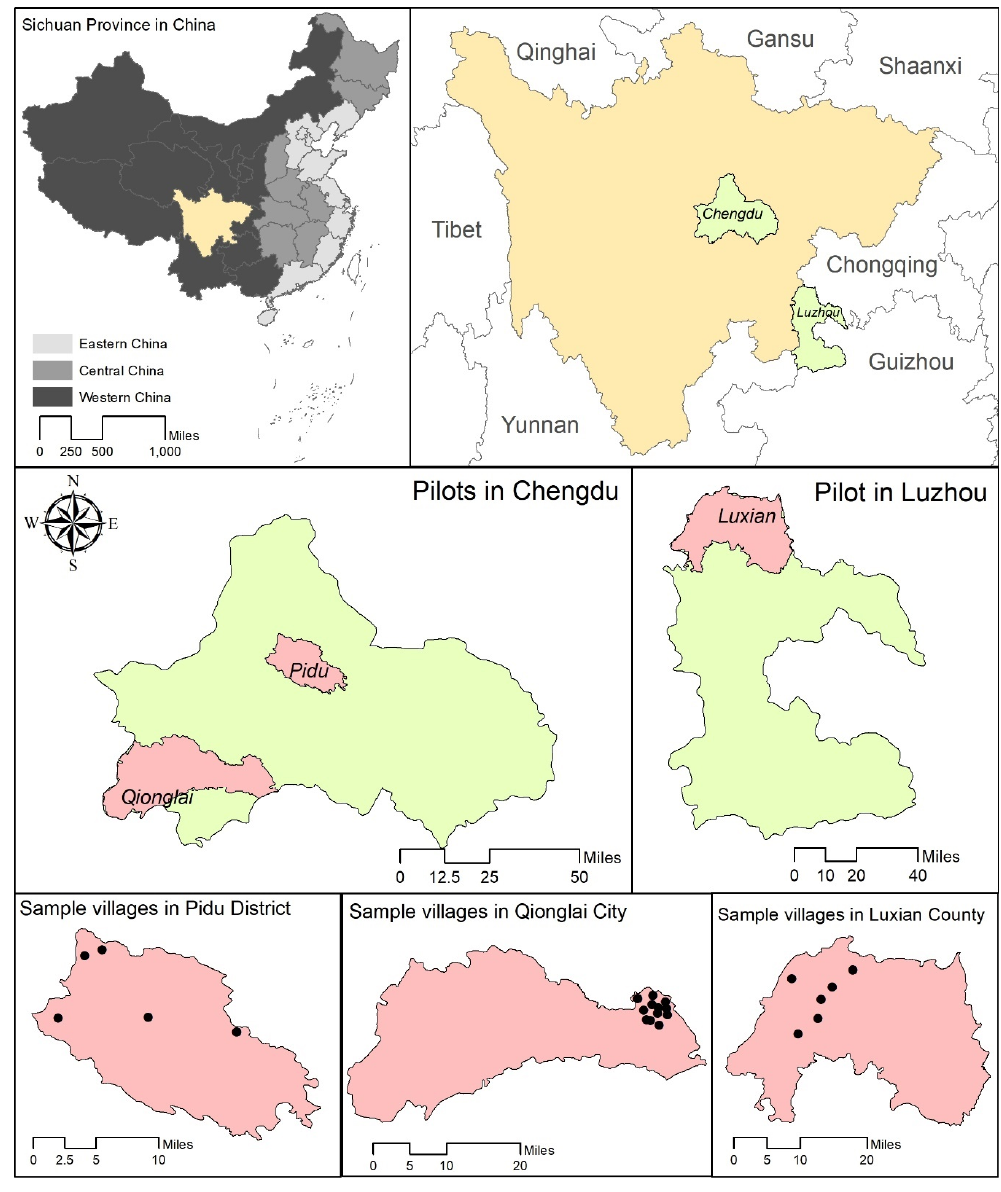
Figure 2. Study area and location of sample villages. Table 1. Profile of survey respondents in sample villages ( n = 308).